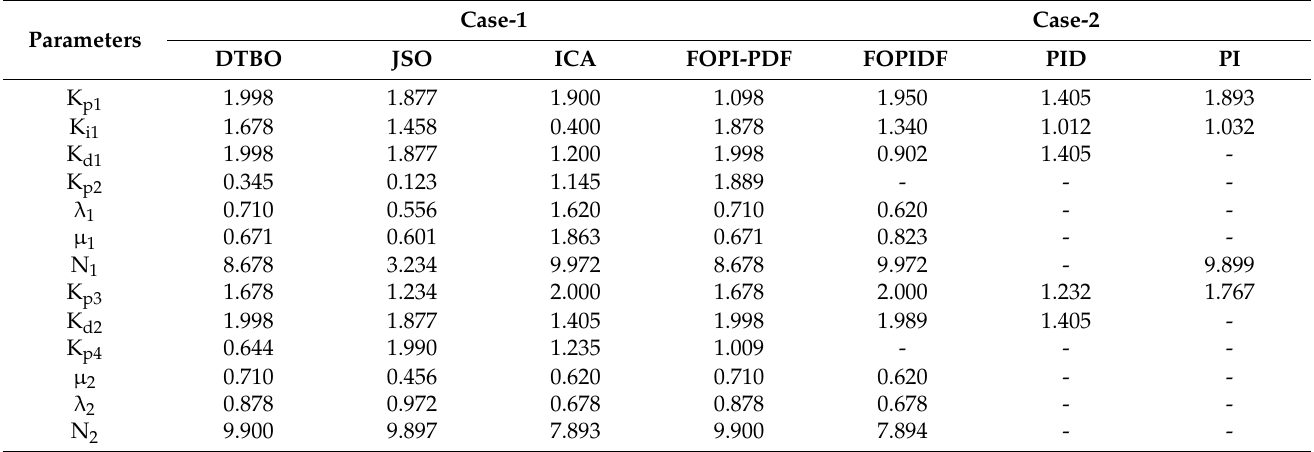
Table 1. Optimal values obtained for the proposed